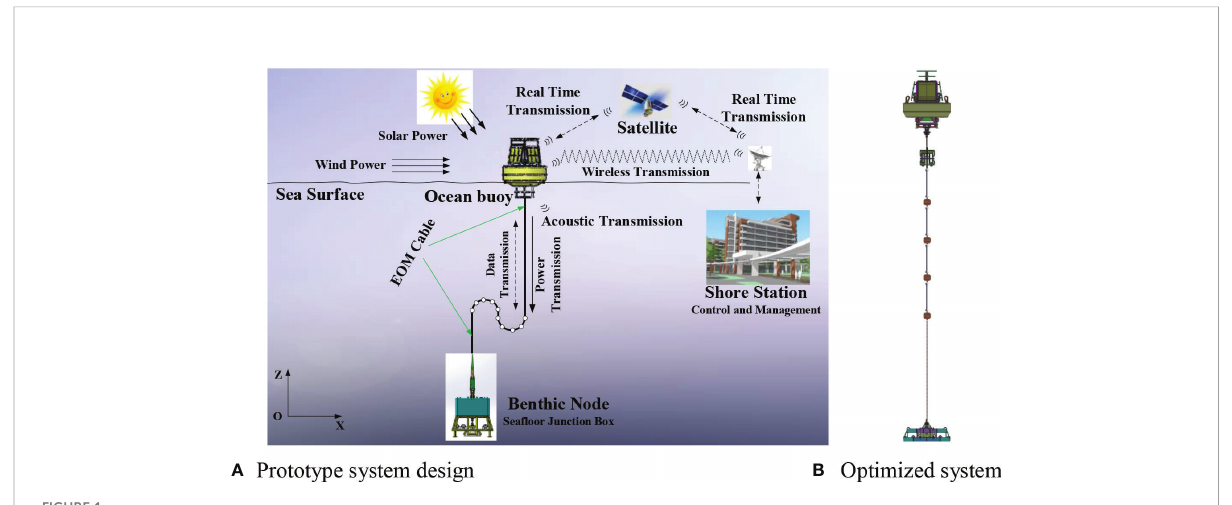
FIGURE 1 Design of MBOSBC. (A) Prototype system design (B) Optimized